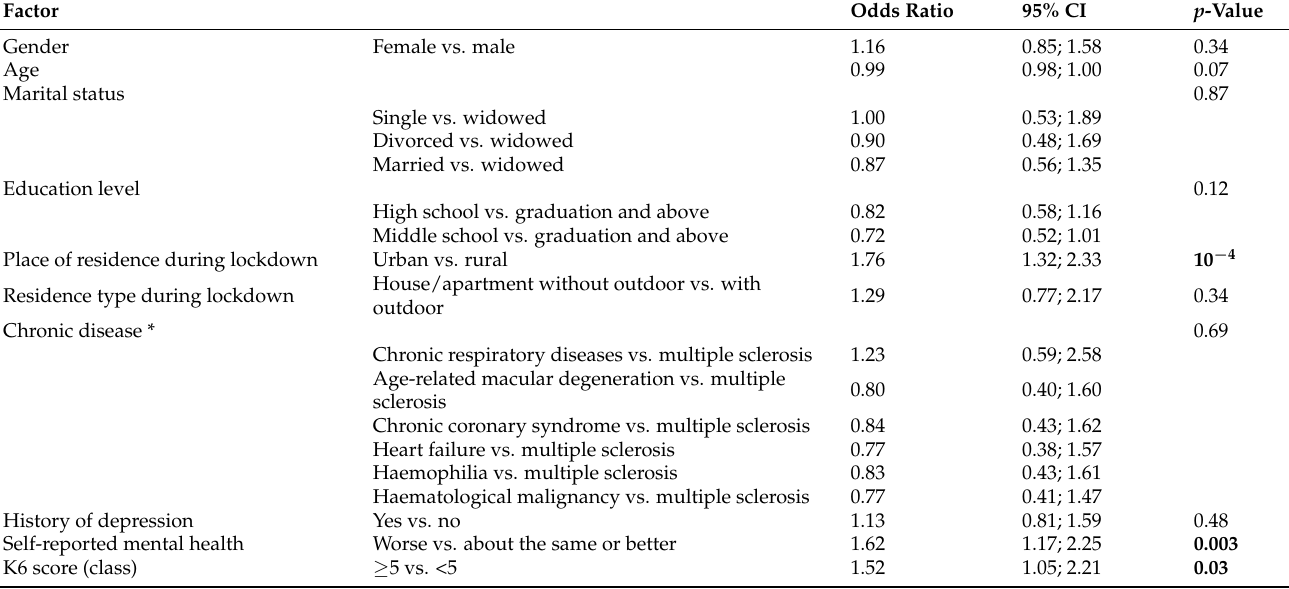
Table 3. Factors associated with at least one unhealthy behaviour: multivariate analysis.